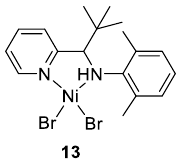
The Zubris group also reported a tert -butyl-substituted amine–pyridine nickel complex with a 2,6-dimethylphenyl group. The bulky amine–pyridine nickel catalyst ( 13 in Figure 9) shows higher activity and produces higher molecular weight PE than the imine–pyridine nickel analog [108].